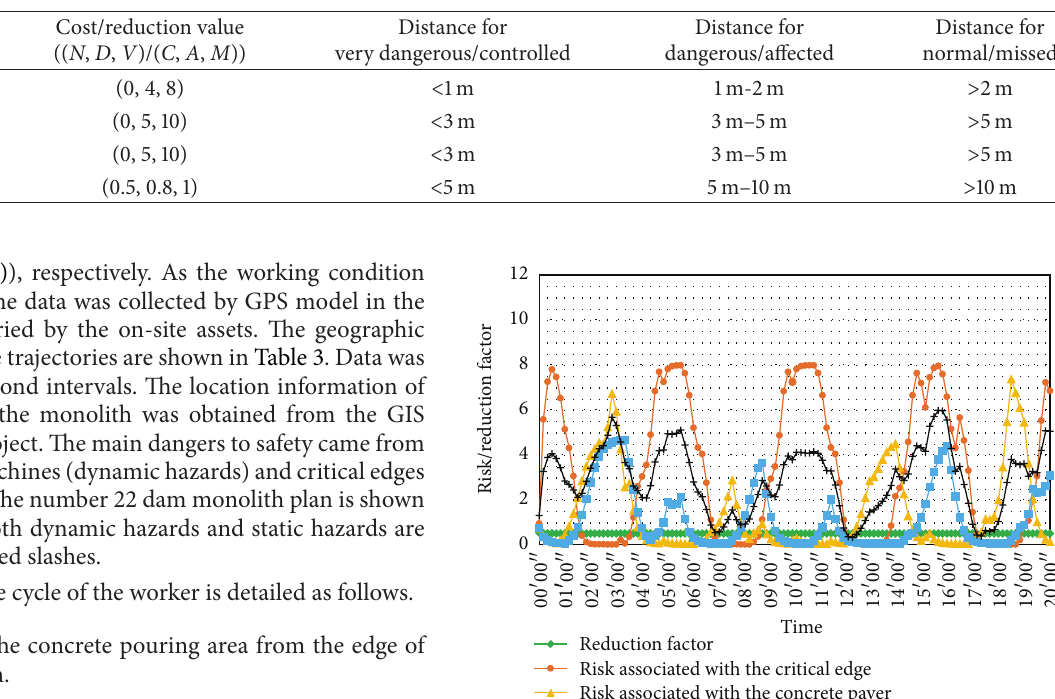
Table 4: Parameters for the safety risk assessment.